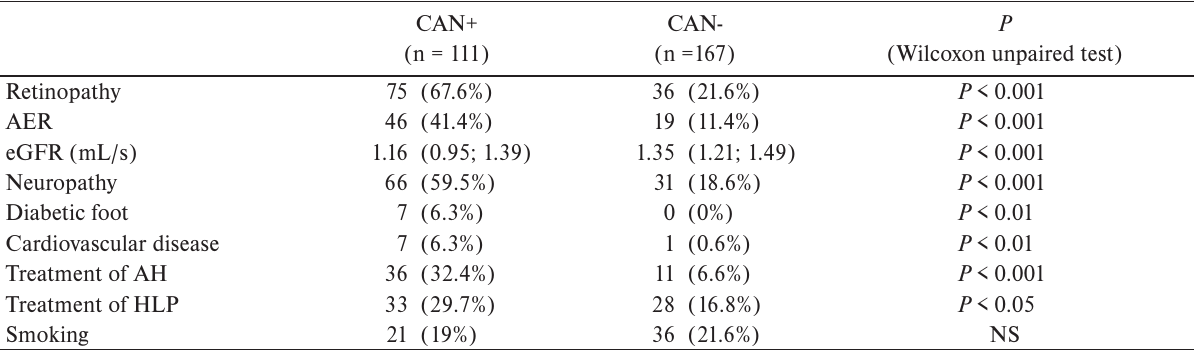
Table 2. Morbidity of group CAN+ and group CAN- at